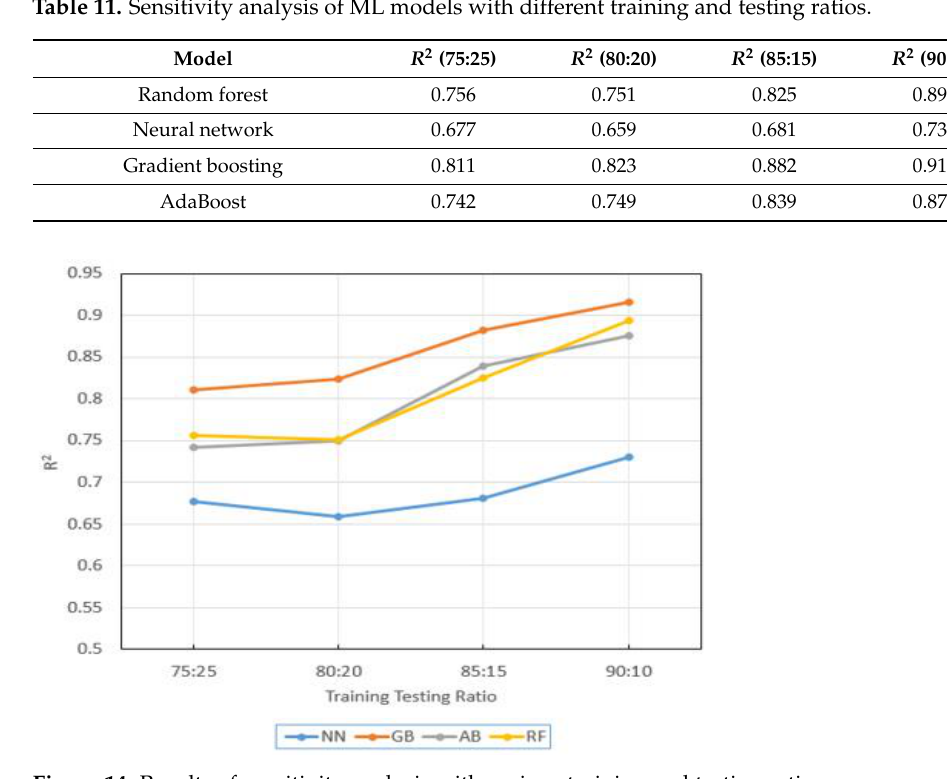
Figure 14. Results of sensitivity analysis with various training and testing ratios.